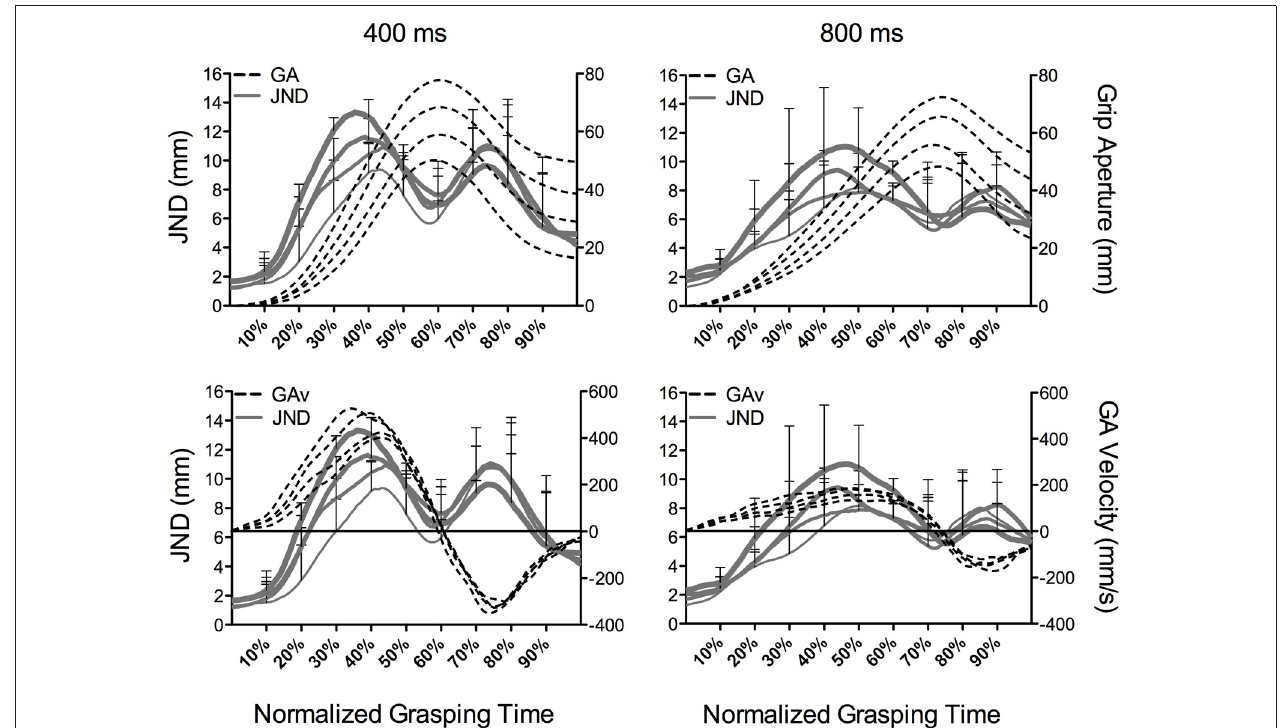
FIGURE 4 | The top panels represent group JNDs (mm: solid lines and left ordinate) and grip aperture (GA) size (mm: dotted lines and right ordinate) and the bottom panels depict JNDs and grip aperture velocities (mm/s: dotted lines and right ordinate) as a function of object size (20, 30, 40, and 50mm) at percentile increments of grasping time in the 400 and 800ms conditions. The